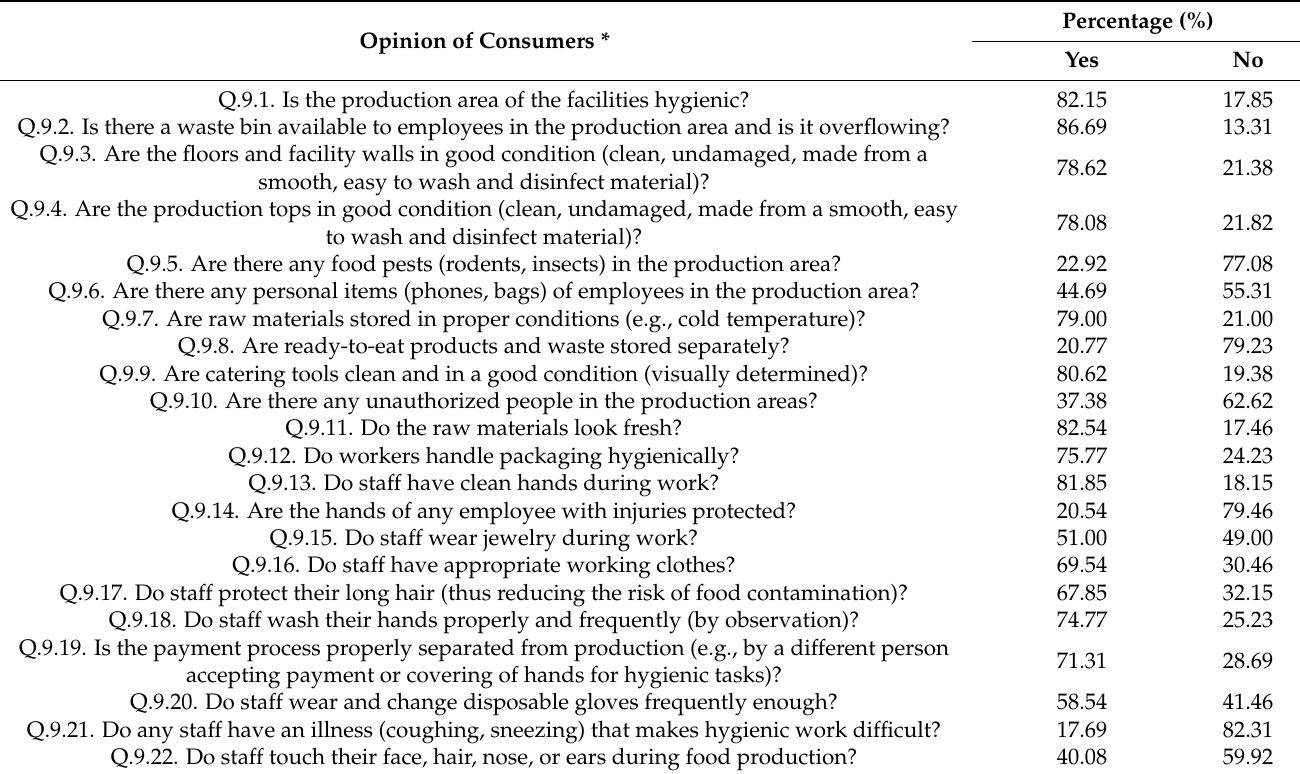
Table 4. The opinion of consumers about the sanitary conditions of street food